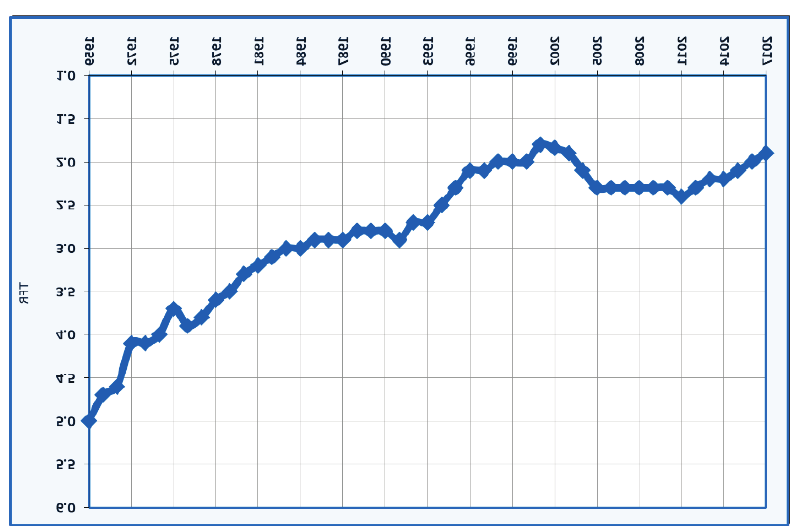
Figure 5. Dynamics of the total fertility rate in Azerbaijan, 1959-2017. Source: according to SSC data.